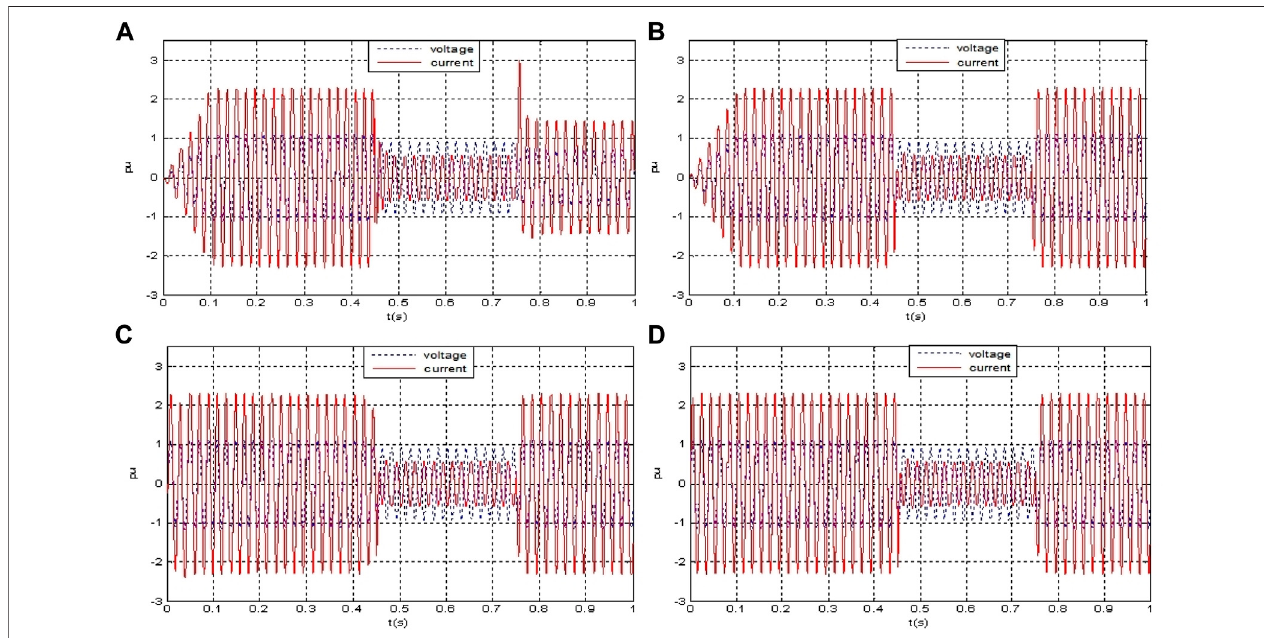
FIGURE 6 | Integrated control chart of microgrid smooth switching. (A) VSG-based microgrid smooth switching control; (B) VSG-based frequency deviation-free control; (C) VSG-based reactive delay smooth switching control; and (D) VSG-based adaptive inertial integrated control.